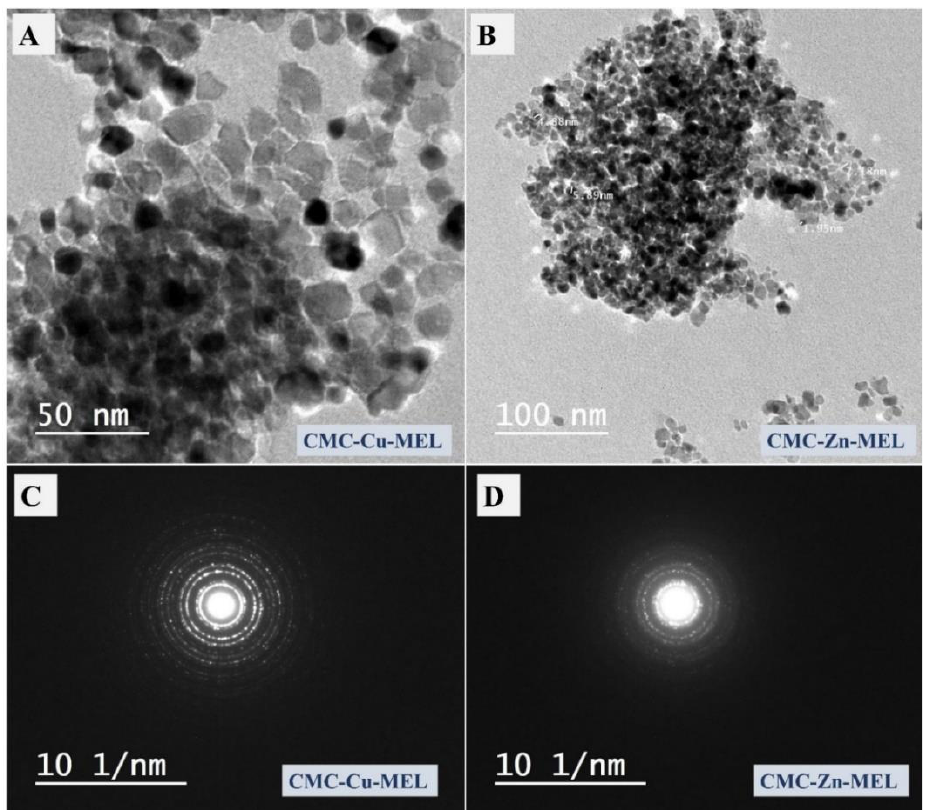
Figure 2. ( A ) TEM image of CMC-Cu-MEL, ( B ) TEM image of CMC-Zn-MEL, ( C ) SAED image of CMC-Cu-MEL, ( D ) SAED image of CMC-Zn-MEL.